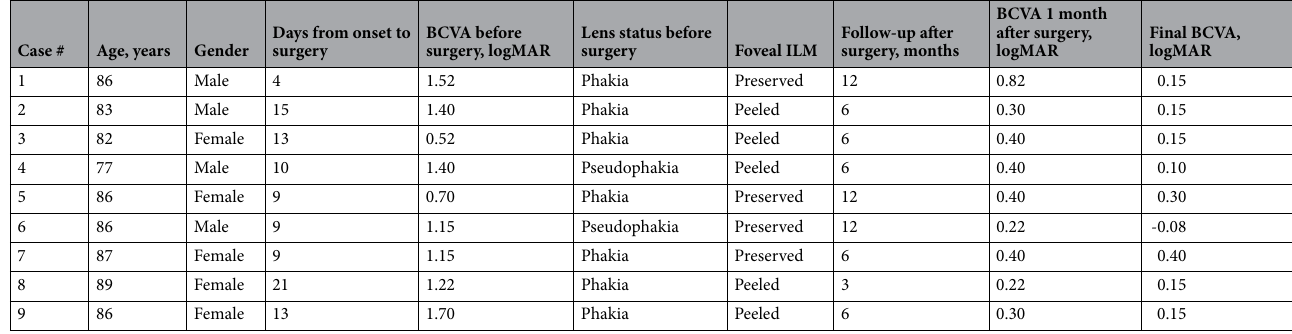
Table 1. Characteristics of the included